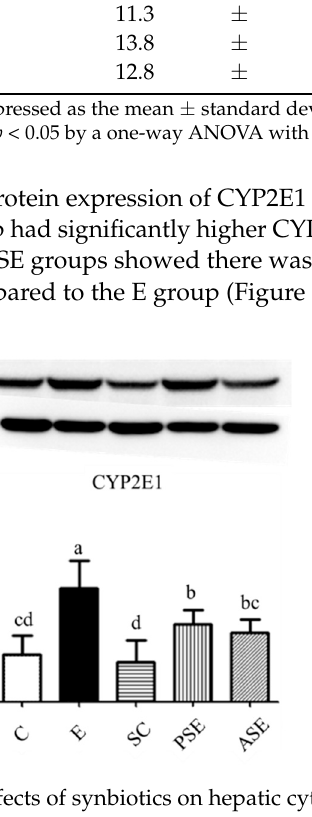
Table 5. Effects of synbiotics on thiobarbituric acid-reactive substances (TBARSs) in rats with chronic ethanol feeding 1 . Groups Plasma ( µ M/mL) Liver ( µ M/mg Protein)